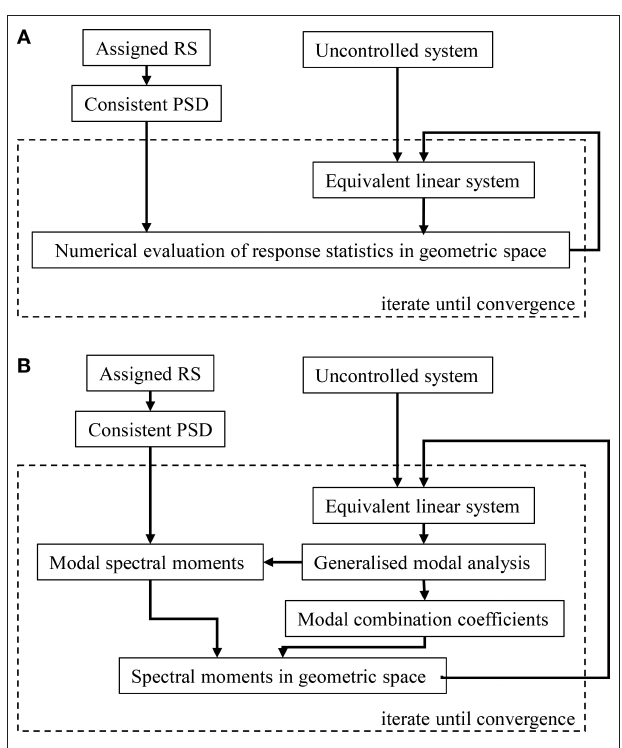
FIGURE 1 | Flowchart for Statistical Linearisation technique. (A) Numerical approach. (B) Proposed